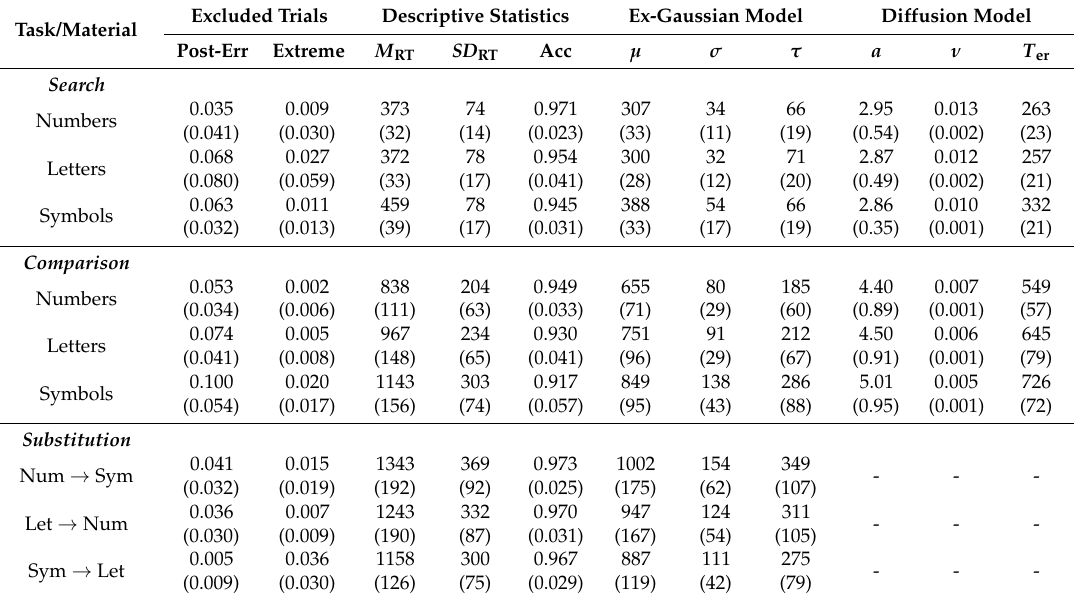
Table 1. Descriptive statistics of response time (RT) scores and model